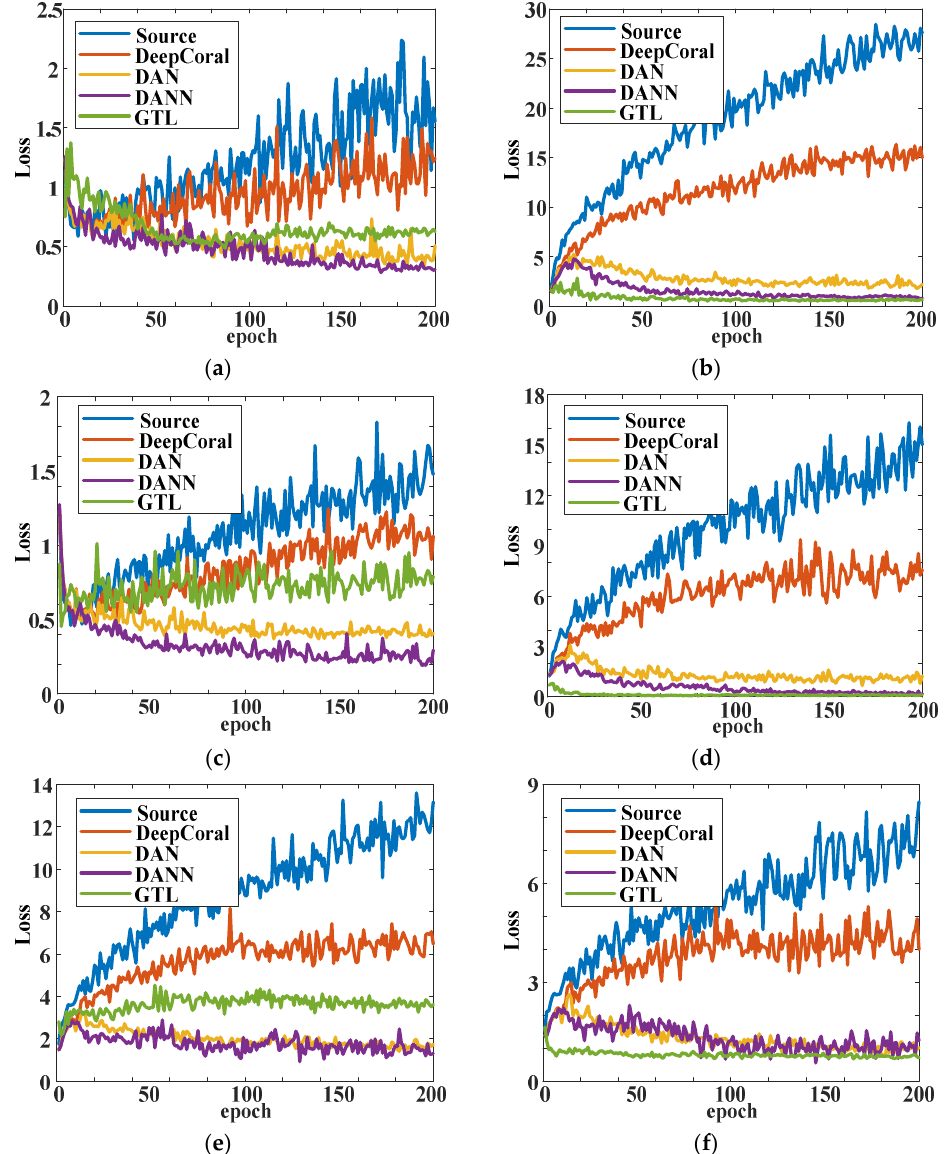
Figure 8. Test loss curve for six transfer tasks: ( a ) H → M; ( b ) H → L; ( c ) M → H; ( d ) M → L; ( e ) L → H; ( f ) L → M.